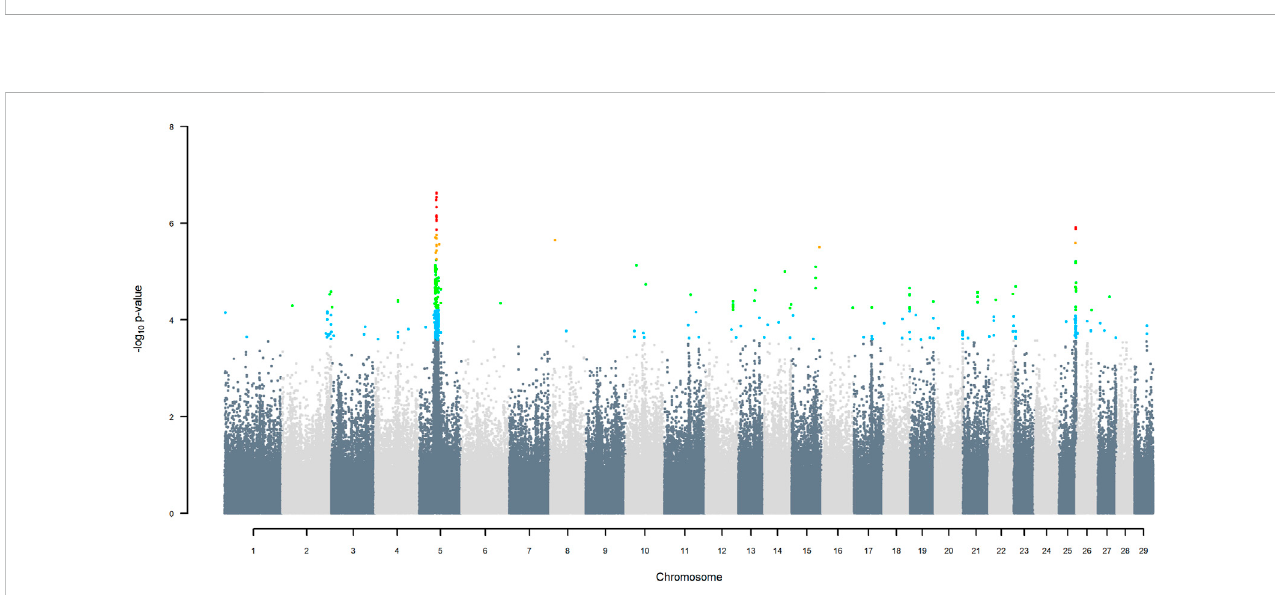
FIGURE 6 Manhattan plotofGWAS (Model3) for indigenous versus HForigin usingSNP alleles ofall origins thathad aMAF > 1%. SNP thatpassed theFDR threshold of 5%, 10%, 20%, and 30% are highlighted in red, orange, green, and blue,